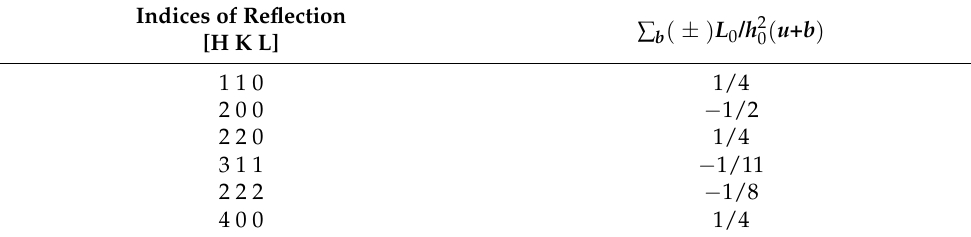
Table 1. Constants for calculating the SFE in f.c.c. structures [59]. Indices of